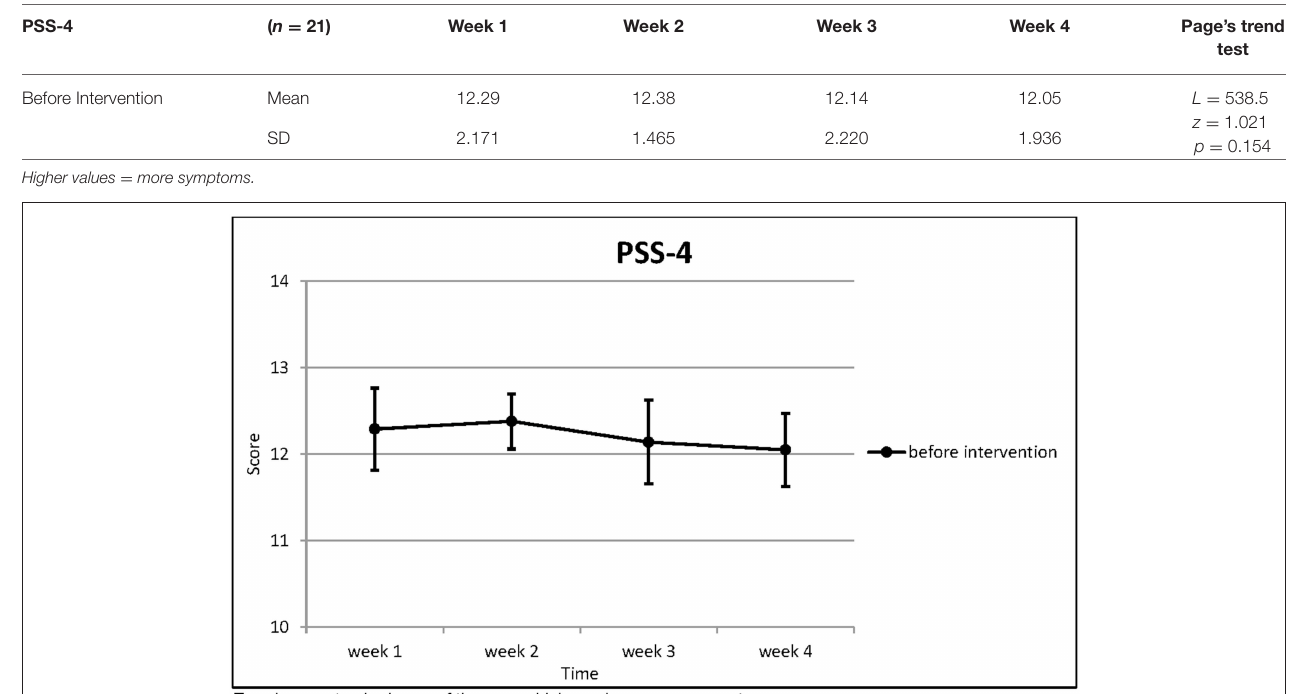
TABLE 6 | Perceived Stress Scale 4.